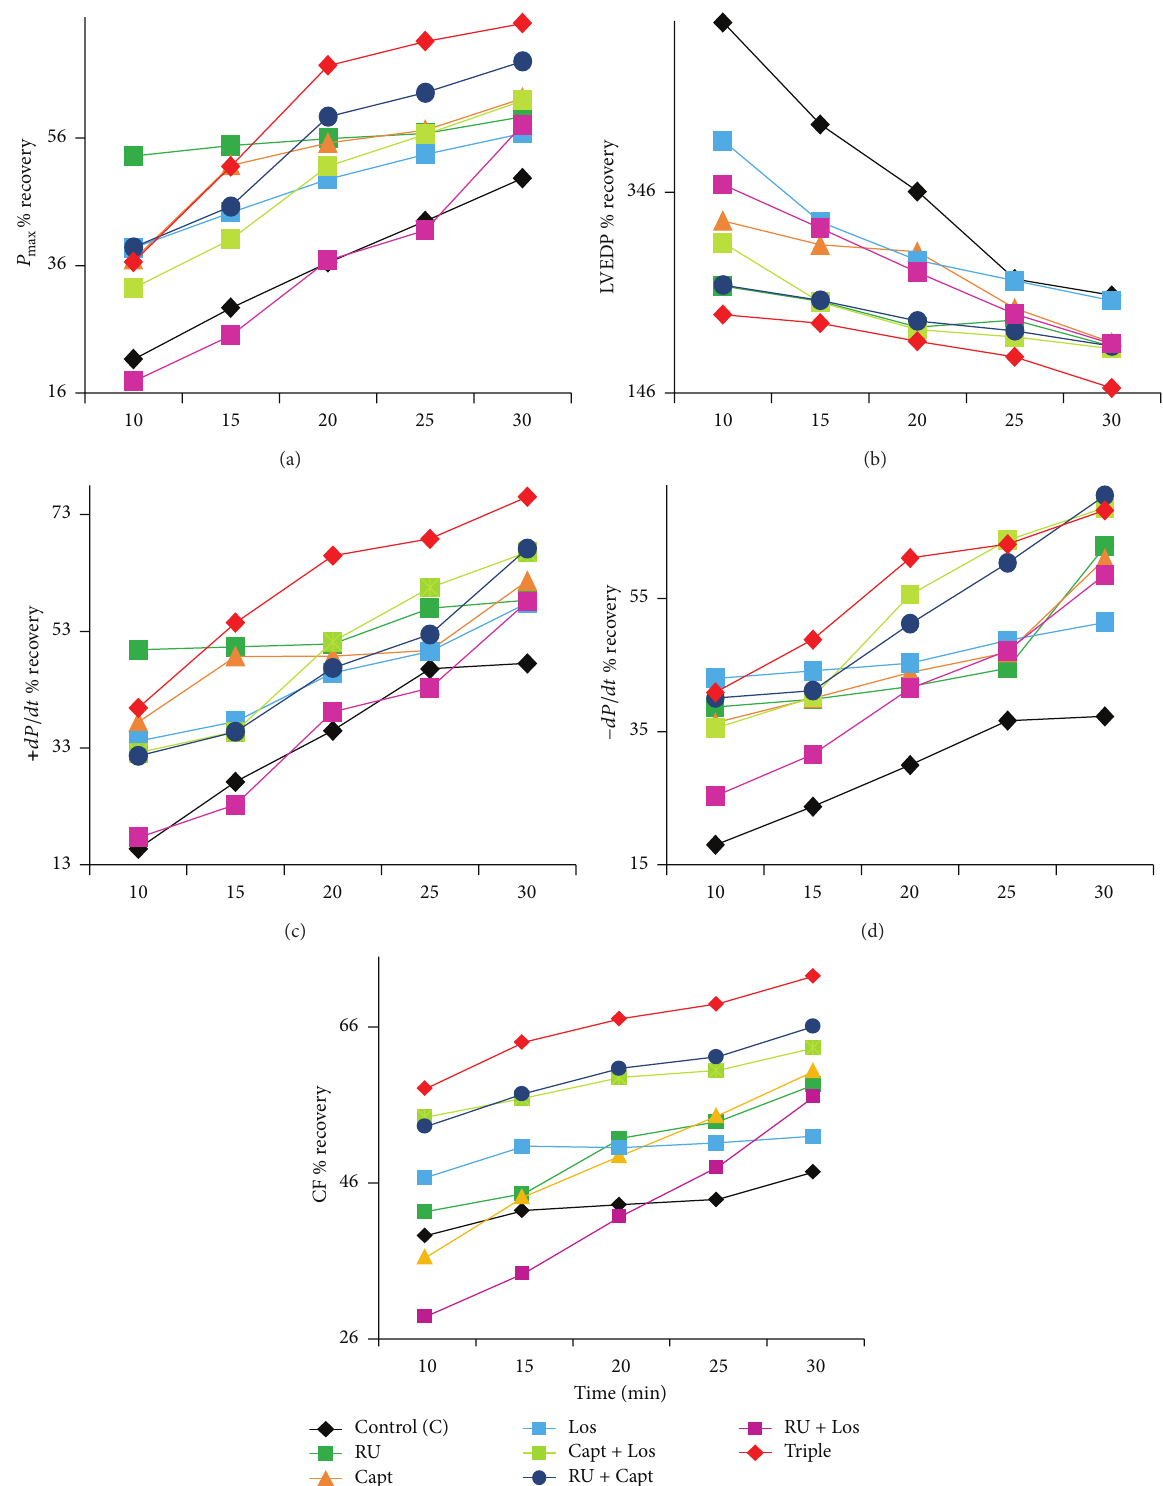
Figure 2: The effect of drugs given after ischemia on % recovery in cardiac function versus reperfusion time for (a) 𝑃 max , (b) LVEDP, (c) +𝑑𝑃/𝑑𝑡 , (d) −𝑑𝑃/𝑑𝑡 , and (e) CF in control hearts. RUL: RU28318; Capt: Captopril; Los: Losartan; Triple: RU28318 + Captopril + Losartan; 𝑃 max : left ventricular developed pressure; LVEDP: left ventricular end-diastolic pressure; negative derivative of pressure; CF: coronary flow; % 𝑅 : % recovery: (reperfusion/baseline) ×